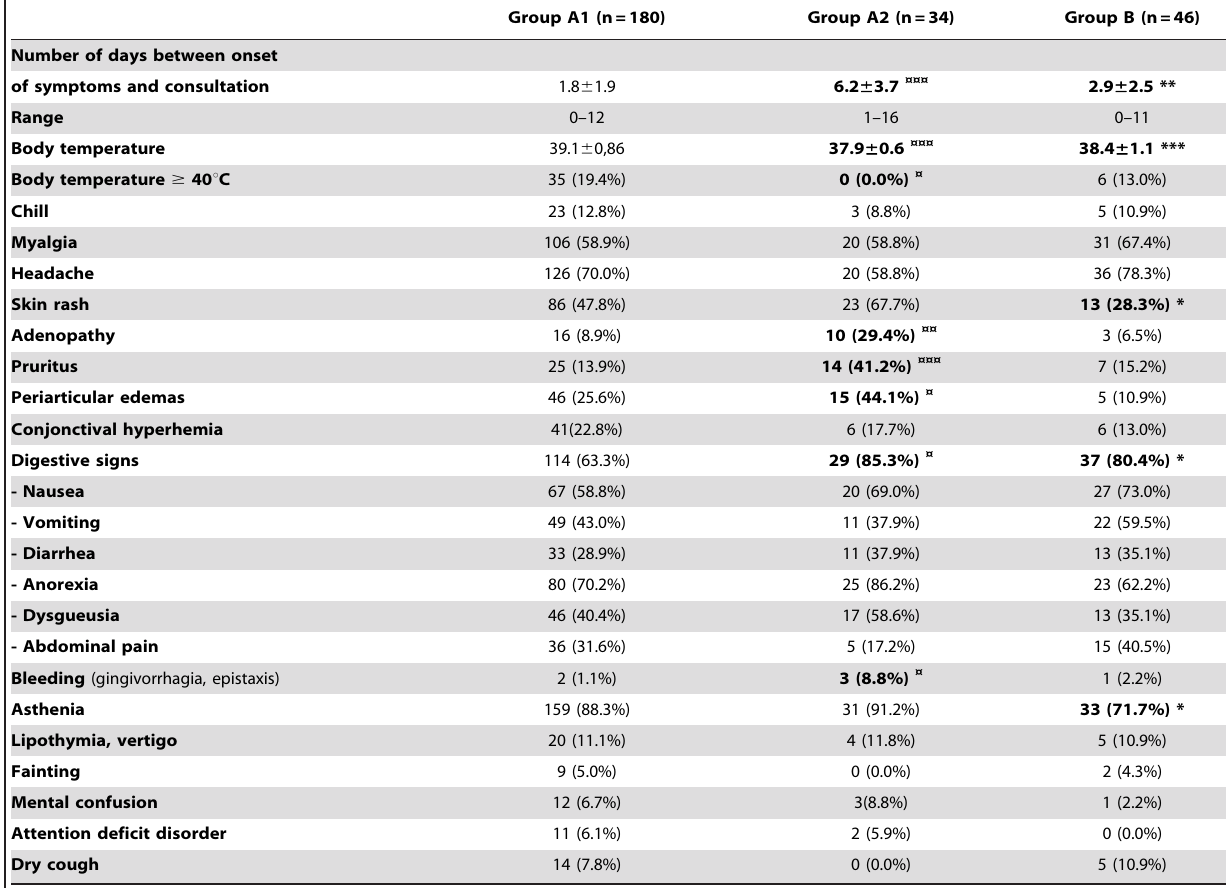
GroupA1:RTPCRCHIKVpositivepatients.GroupA2:RTPCRCHIKVnegative,IgMantiCHIKVpositive,IgGantiCHIKVnegativepatients.GroupB:RTPCRCHIKV negative,IgMantiCHIKVnegative,IgGantiCHIKVnegativepatients. GroupA1vsGroupA2: ¤¤¤ p , 0.001, ¤¤ p , 0.01, ¤ p , 0,05. GroupA1vs.GroupB: *** p , 0.001,**p , 0.01,*p , 0,05. Average,standarddeviation,percentageinparenthesisareindicated.